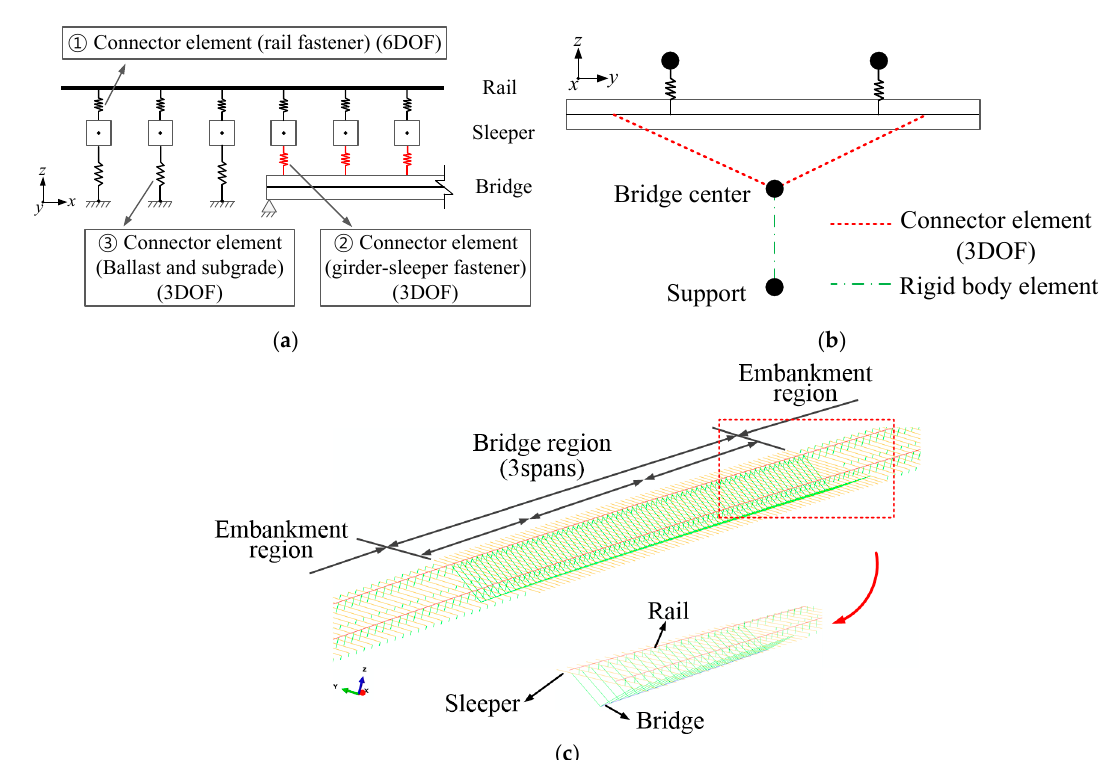
Figure 7. Schematic view of FE model: ( a ) side view; ( b ) cross-section; and ( c ) example of FE model. UIC 60 rail was used in the analysis. The area and the moment of inertia in the strong and weak axes of the UIC 60 rail were 76.86 cm 2 , 3055 cm 4 and 513 cm 4 , respectively. The elastic modulus, thermal expansion coefficient, and Poisson’s ratio of the rail were 210,000 MPa, 1.14 × 10 − 5 /°C, and 0.3, respectively.